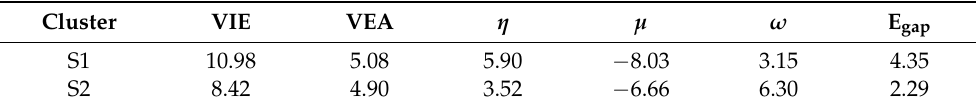
Table 1. Global reactivity descriptors (GRDs) of the structural isomers S1 and S2 of Ti 6 O 12 cluster in gas phase. All quantities are given in